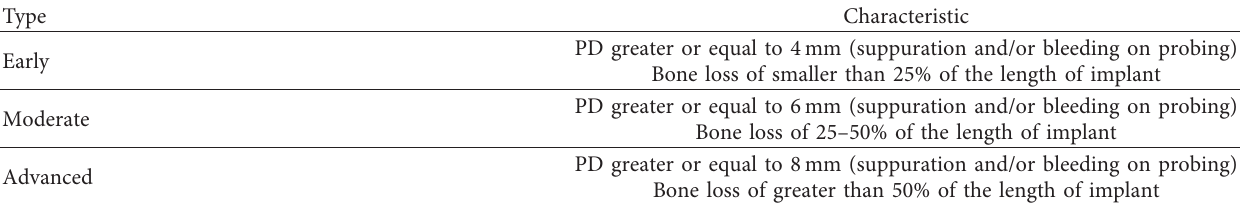
Table 3: Peri-implant disease